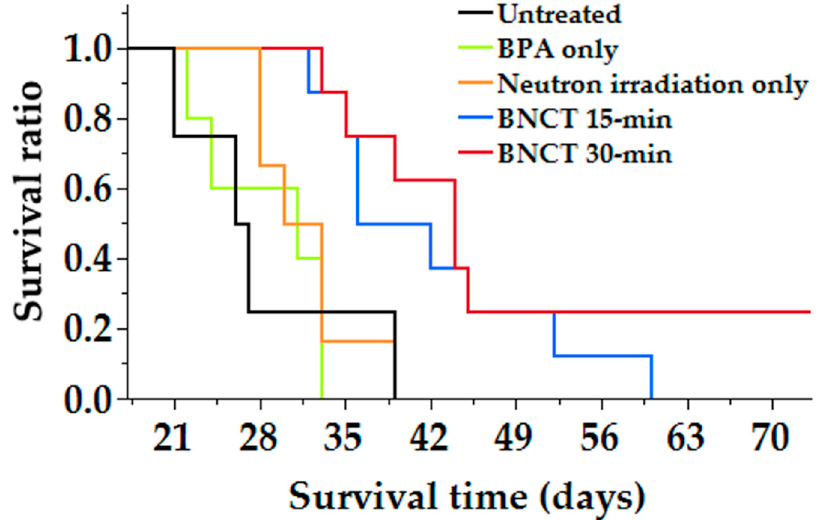
Figure 5. Kaplan–Meier survival curves of mouse CNS lymphoma models after neutron irradiation. Survival times in days after tumor implantation were plotted for the following groups: untreated control (black line), BPA only (green line), neutron irradiation only (orange line), BNCT 15-min: BPA exposure followed by 15 min of neutron irradiation (blue line), and BNCT 30-min: BPA exposure followed by 30 min of neutron irradiation (brown line). Median survival times of untreated control group, BPA only group, Neutron irradiation only group, BNCT 15-min group, and BNCT 30-min group were 28.2 ± 3.8, 28.6 ± 2.3, 31.8 ± 1.7, 42.3 ± 3.4, and 41.3 ± 1.8 days. There were statistically significant differences between the BNCT 30-min group and untreated control group ( p = 0.007) and between the BNCT 15-min group and untreated control group ( p = 0.02). Table 1. Survival times of mouse CNS lymphoma models after neutron irradiation.